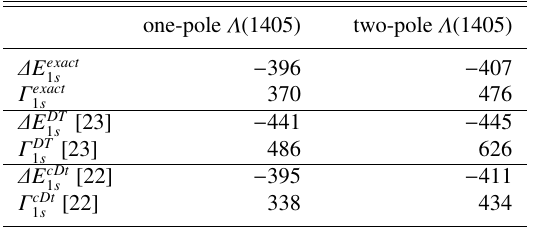
Table 2. Kaonic hydrogen 1 s level shift ∆ E (eV) and width Γ (eV), corresponding to the obtained scattering length: exact ([11] and this work), derived from Deser-Trueman formula [23], and from corrected Deser-Trueman formula